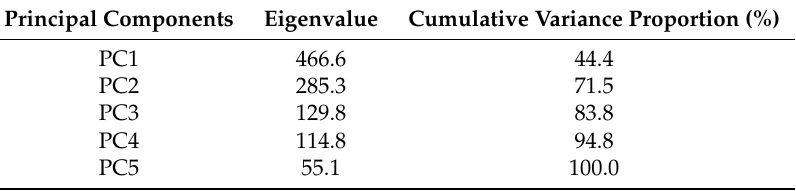
Table 2. Descriptive statistics of five principal